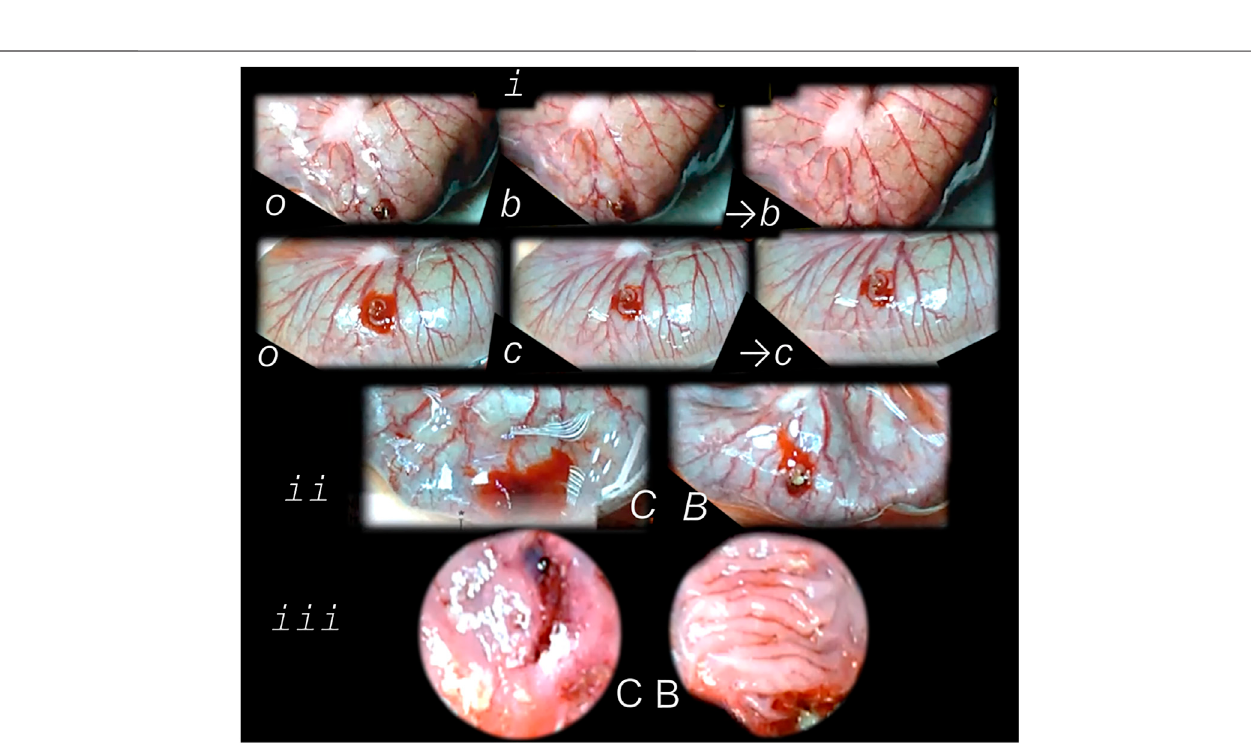
FIGURE 6 | Perforated cecum defect and BPC 157 therapy effect. i . Presentation of the perforated cecum defect ( o -immediately after perforation, before therapy) as an illustration of the rapid healing effect immediately after wounding, with vessels “ running ” toward the defect augmented by BPC 157 bath application (10 μ g/kg) (USB microcamera). b — vessels recruitment presentation immediately under the immersion of the BPC 157 bath, which had been applied at the cecum, and presentation immediately thereafter → b ) with corresponding controls (saline bath 1 ml/rat) presentation c, → c ). ii . Resultant bleeding from the perforated defect ( C (controls),decreasedinBPC157rats(B). iii .Finalfailureoftheperforateddefecthealingincontrols(C)(postinjuryday7)andcompletelyhealeddefectinBPC157rats(B). This bene fi cial effect goes along with counteraction of the worsening effect of both NOS-blocker L -NAME (5 mg/kg), or NOS substrate L -arginine (100 mg/kg) (directly applied to the perforated cecum, alone or combined, and spread through the abdominal cavity), and normalization of the increased MDA- and NO-values in the cecum (Drmic et al., 2018).